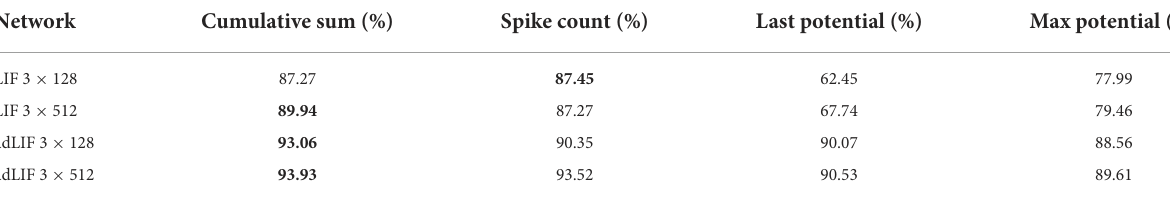
TABLE 1 Results on the SHD dataset for SNNs with different types of readout